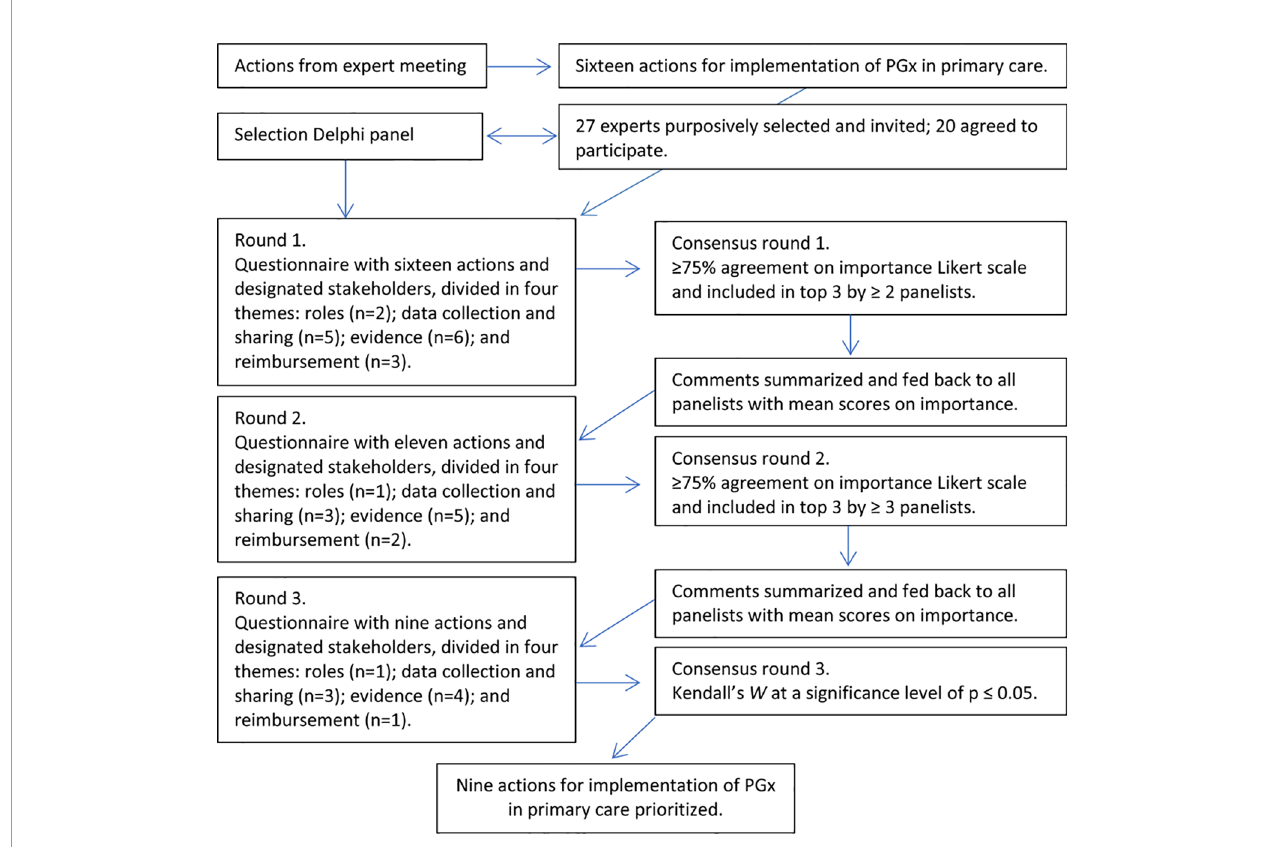
FIGURE 3 | Steps of the Delphi procedure including cutoff